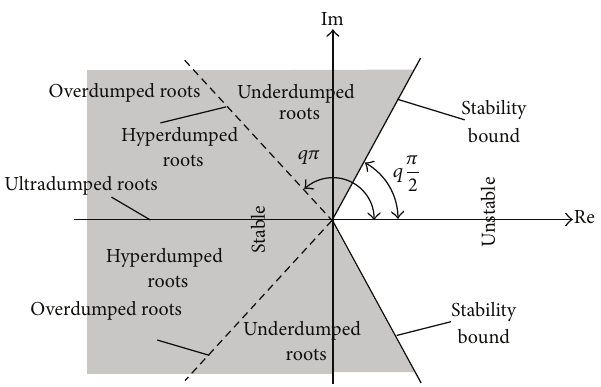
Figure 1: Stability regions of fractional-order systems with frac- tional commensurate order 𝑞 .